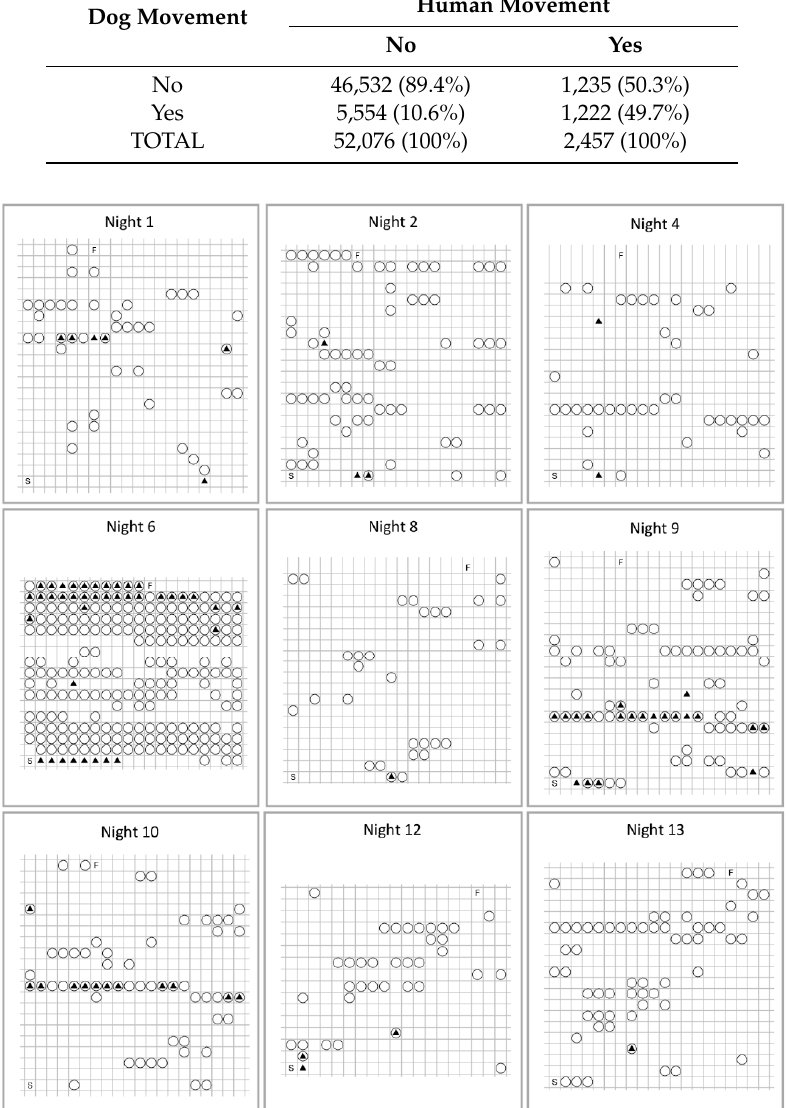
Table 1. Cross tabulation of simultaneous human and dog movement.